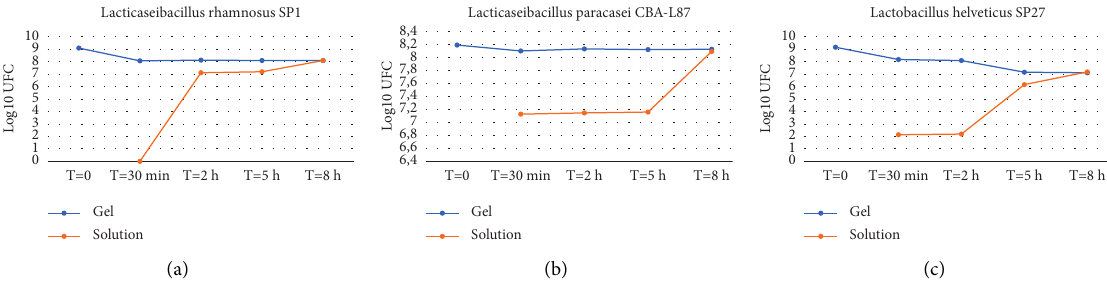
Figure 4: Enumeration of viable Lactobacillus from various lipogel preparations. Measurements were performed with LCA for the bacteria within the lipogels (blue line) and with both LCA and plate-spreading in agar for the bacteria released in solutions ( Y -axis) at different time points ( X -axis). Gel: lipogel preparations loaded with bacteria. Solution: artificial saliva was prepared according to Marques et al. [42]. Values are expressed as mean of three independent experiments. Table 2: Lyophilized mixture of probiotics enumerated through colony-forming units (CFUs) and Lacto-Counter Assay (LCA). Species Strains CFUs/g Bacteria/g; LCA